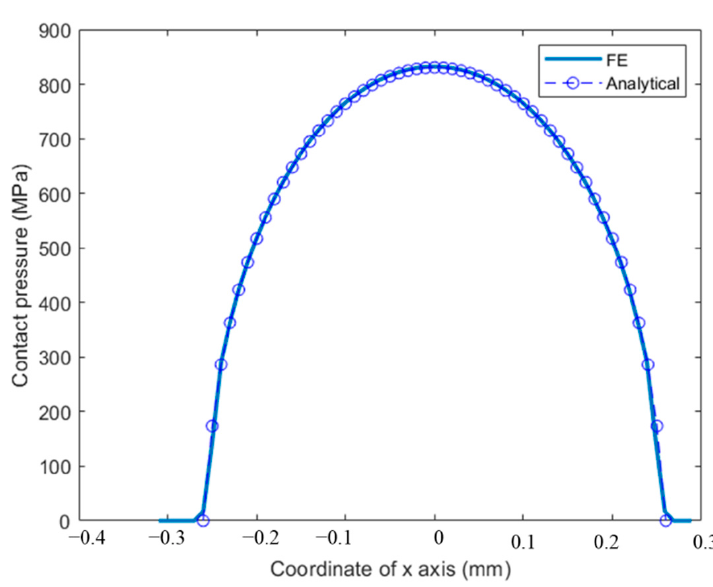
Figure 8. Contact pressure comparison between the FE model and analytical solution when P = 1000 N.